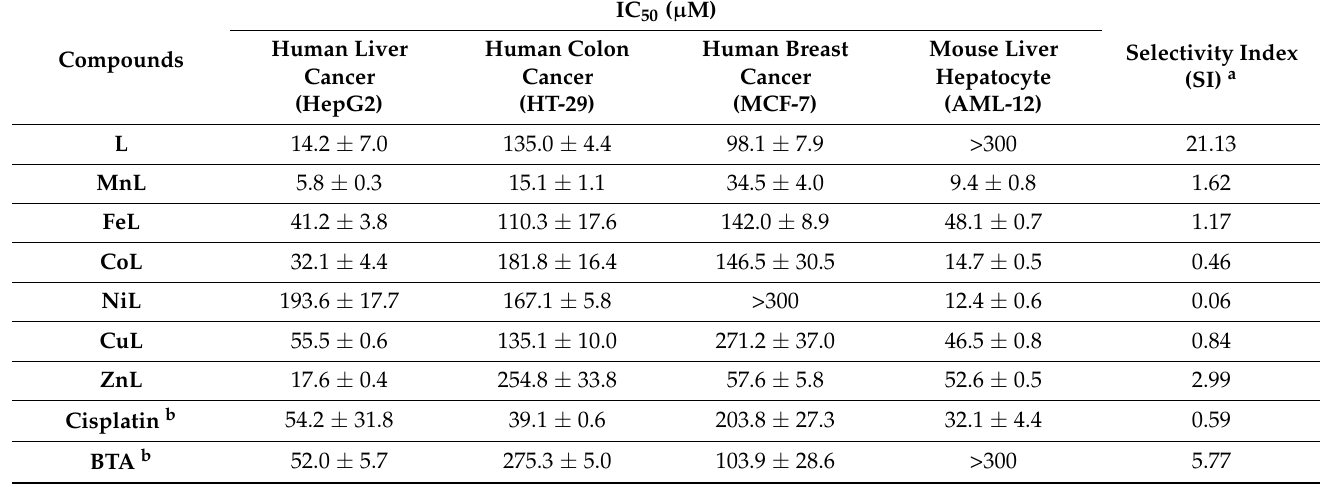
Table 1. Half inhibitory concentration (IC 50 ) of the ligand and transition metal complexes in cancer and normal cells. For each cell line, the IC 50 values are the averages of three independent experiments [( n = 3, mean ± SEM (standard error of the mean)]. Cisplatin and BTA were used as positive controls, and the selectivity index (SI) in HepG2 cells is